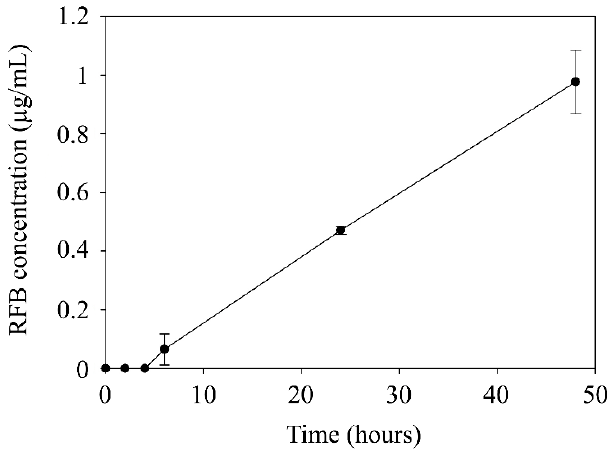
Figure 8. Permeation profile of rifabutin (RFB) loaded in NLC across Caco-2 cell monolayers expressed as a function of drug concentration in the lower compartment in a 48-h time interval.